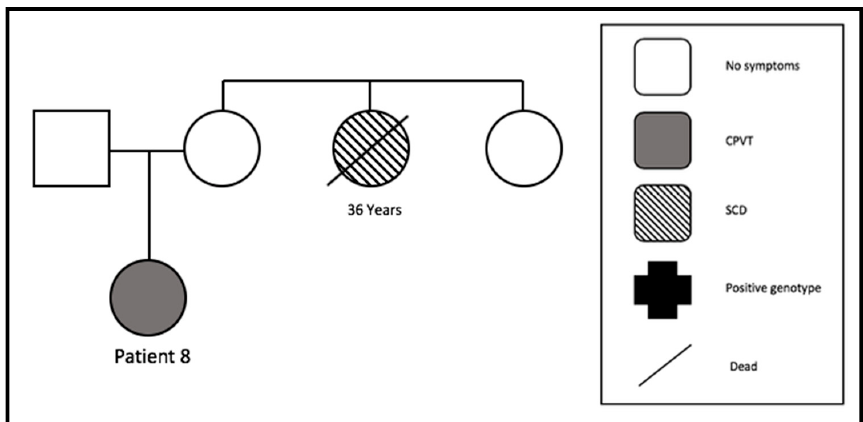
Figure 4. Pedigree of family 6. One SCD at the age of 36 years (SCD = sudden cardiac death).